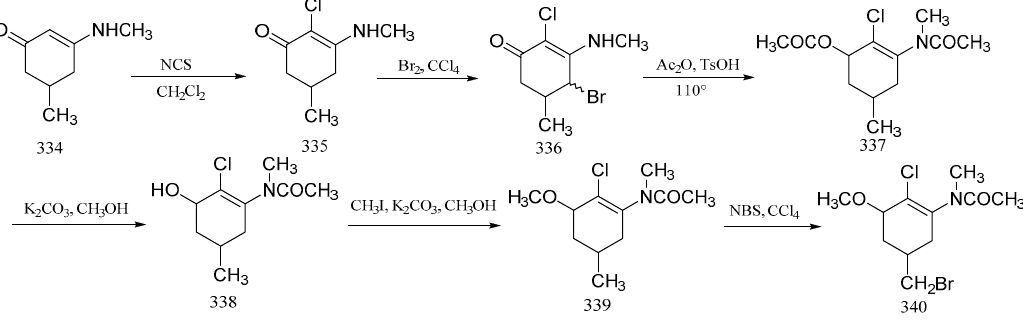
Figure 17. Synthesis of the aromatic portion of maytansine.